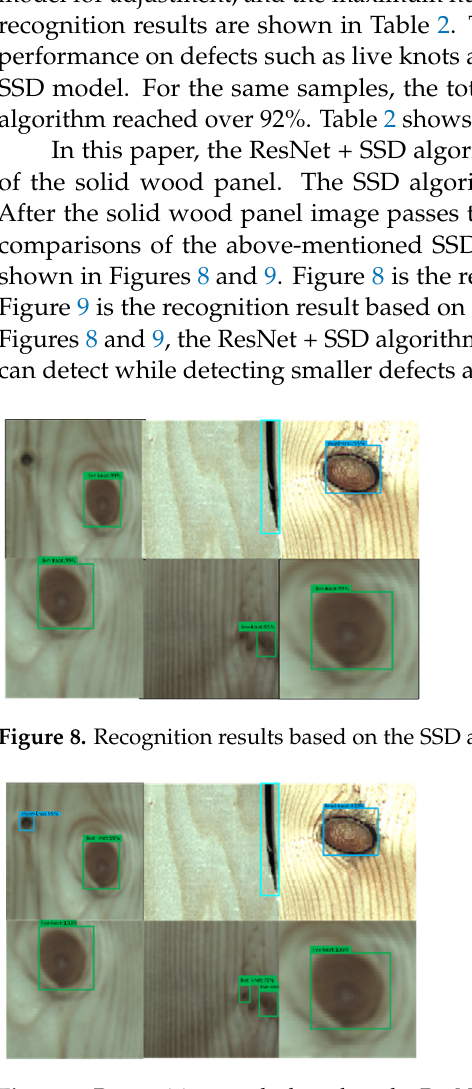
Table 2. Detection results of the detection model.